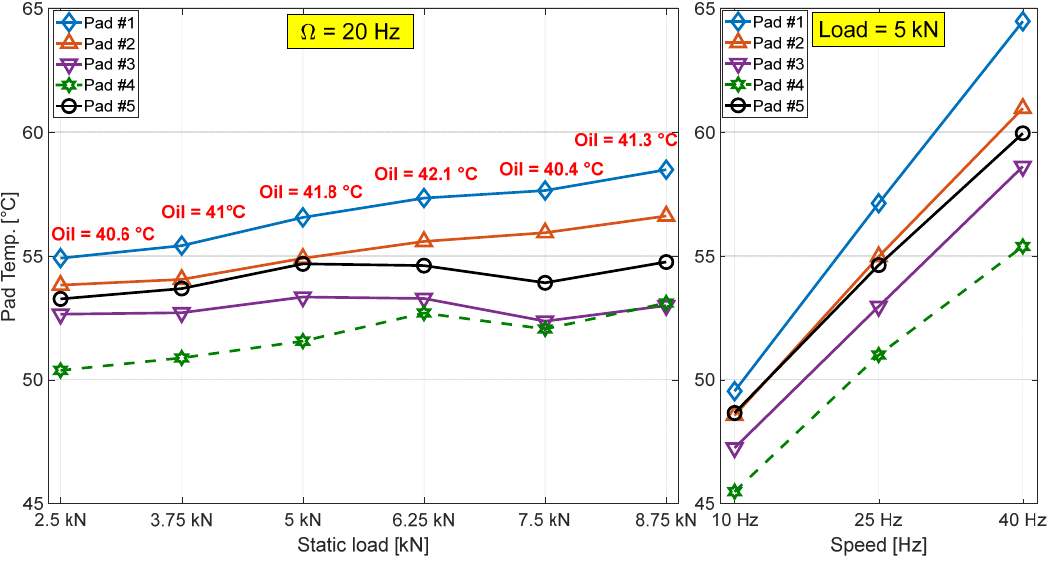
Figure 16. The measured temperature of each pad vs. static load ( left ) and rotational speed ( right ) in the test bearing.